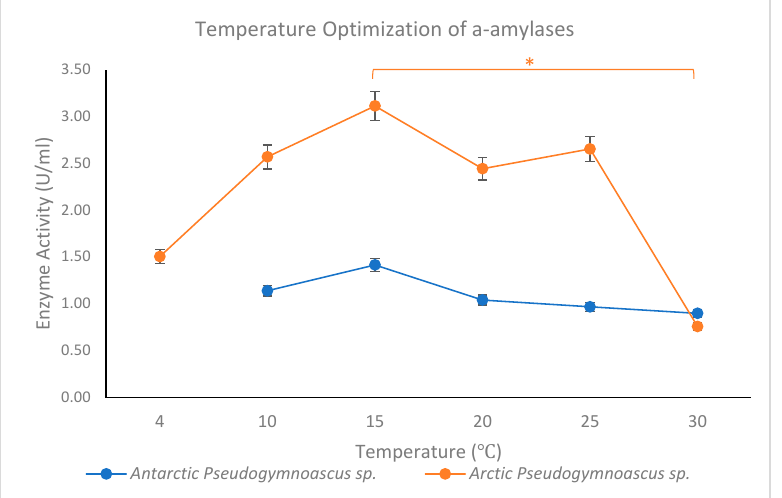
Figure 1. Temperature optimization of α -amylase obtained from Antarctic Pseudogymnoascus sp. and Arctic Pseudogymnoascus sp. (* p < 0.05).